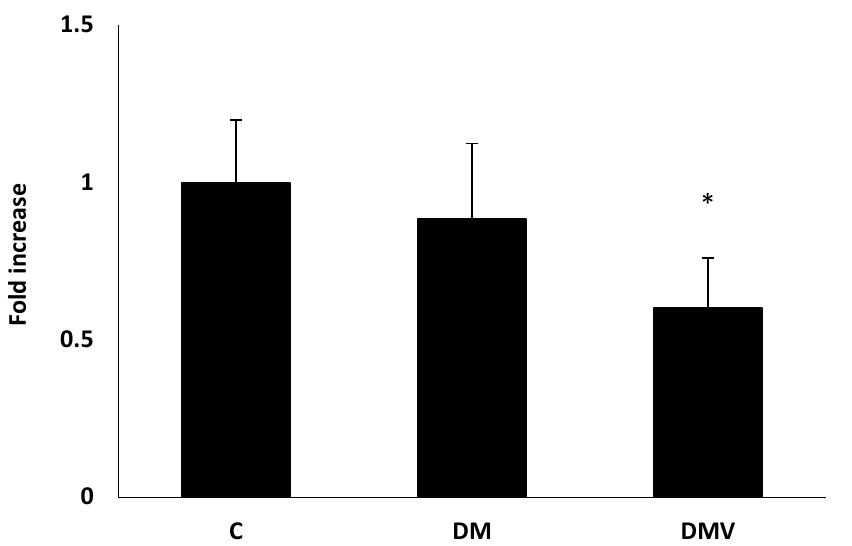
Figure 1. The expression level of hepcidin mRNA in the liver. Values shown are represented as mean ± SD, C (Control rats); DM (diabetic STZ rats); DMV (diabetic STZ rats treated with 1 mg V/day). * Different expression level compared to the C and DM groups C (Mann–Whitney-U test). p < 0.05.